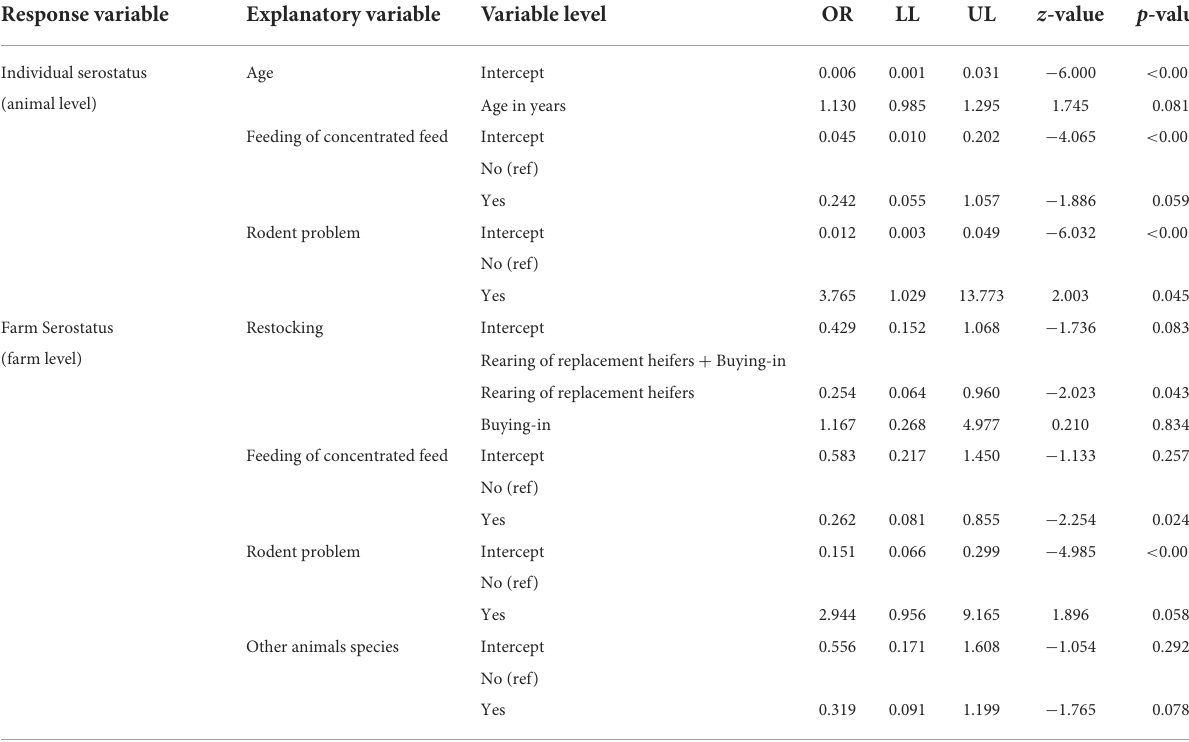
TABLE 4 Models that rendered a p -value ≤ 0.1 (“ref” reference, “OR” odds ratio, “LL” and “UL” lower limit and upper limit of 95% confidence